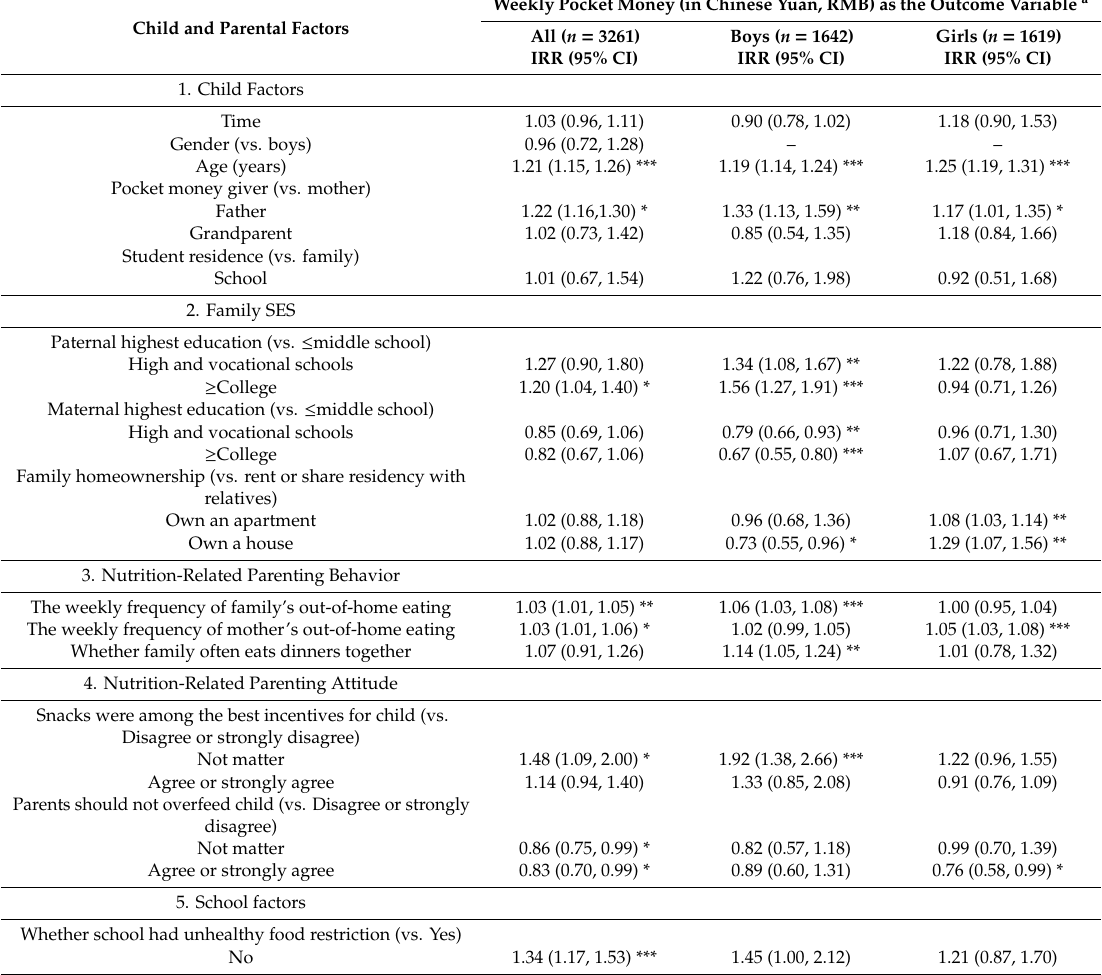
Table 2. Factors associated with pocket money (incident rate ratio (IRR) and 95% CI) among children: The Childhood Obesity Study in China Mega-Cities,